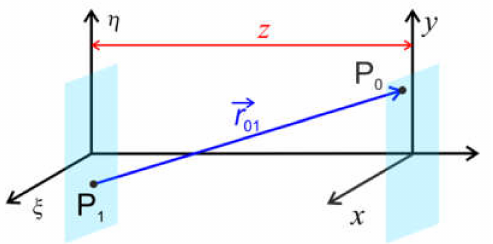
Figure 6. Schematic of symbols used in the Huygens-Fresnel principle, and the Fresnel and Fraunhofer di ff raction